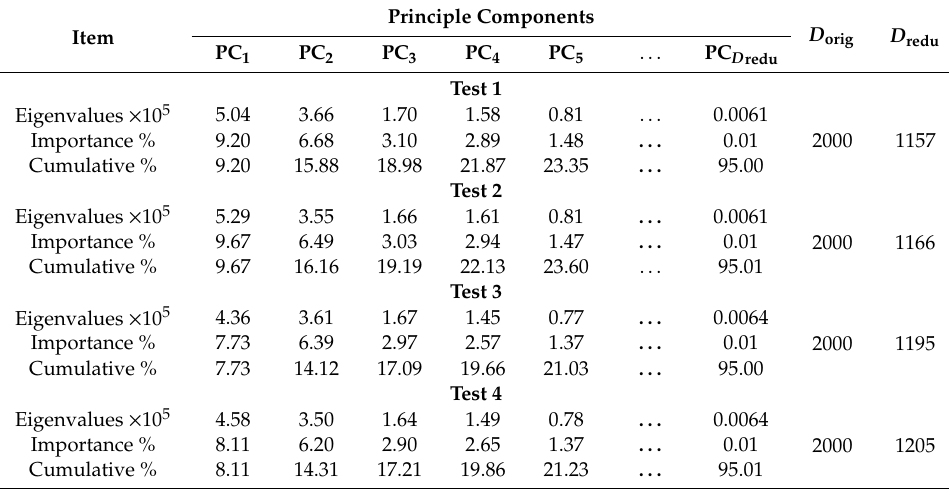
Table 2. Results of principle components for test 1 to test